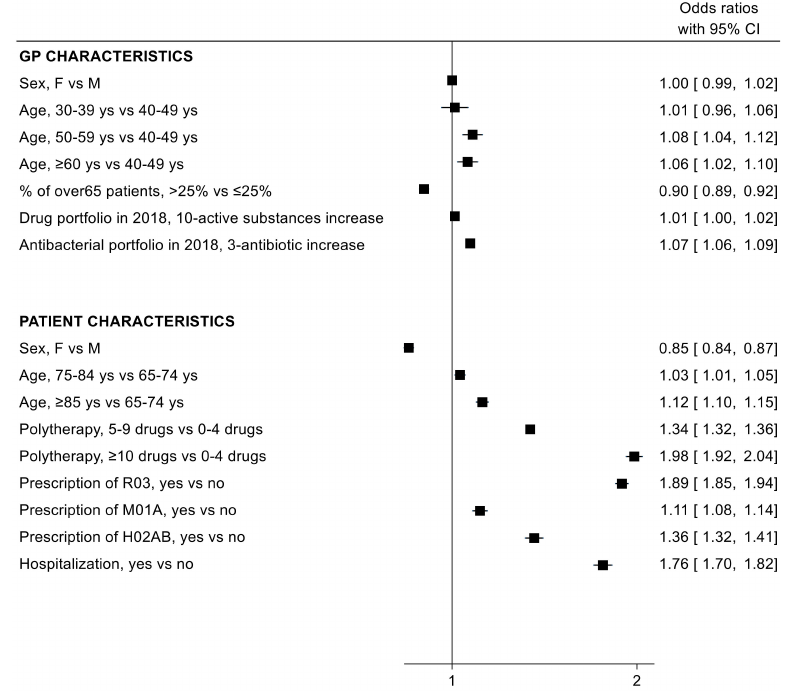
Figure 3. Odds ratio (OR) and 95% confidence intervals (95% CI) for the association between patient/general practitioner (GP) characteristics and the probability of being exposed to at least one fluoroquinolone (J01MA)